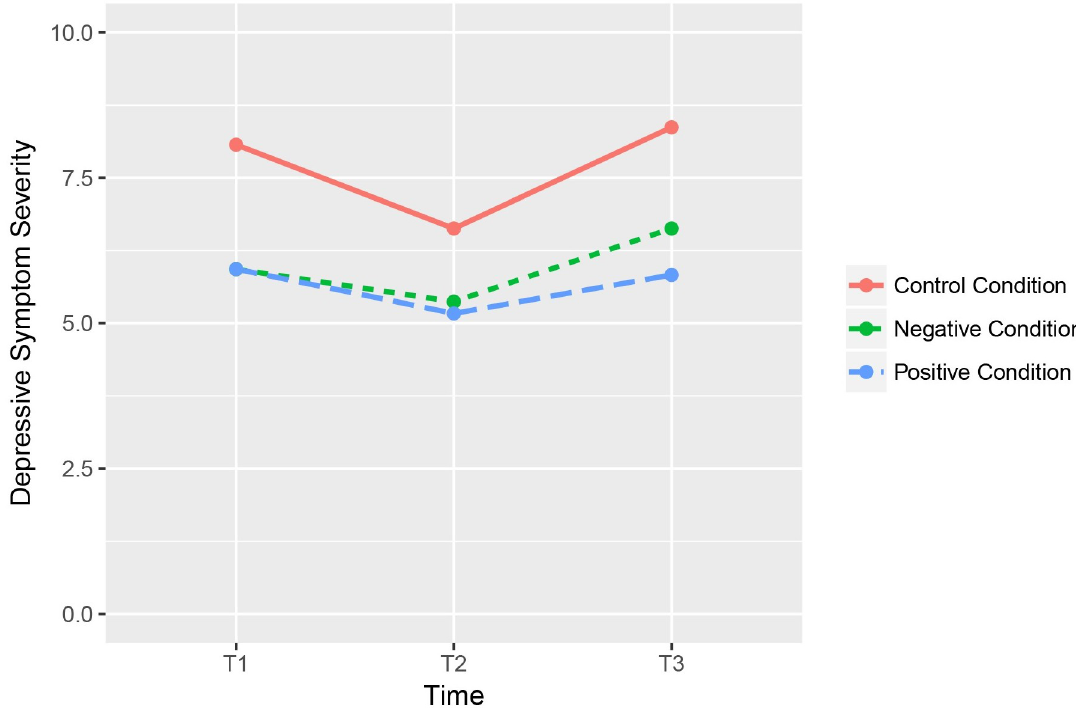
Fig 2. Differences in participants’ depressive symptom levels (as measured with the PHQ-9), before (T1), immediately after (T2), and one month after (T3) the ESM protocol, for each condition.